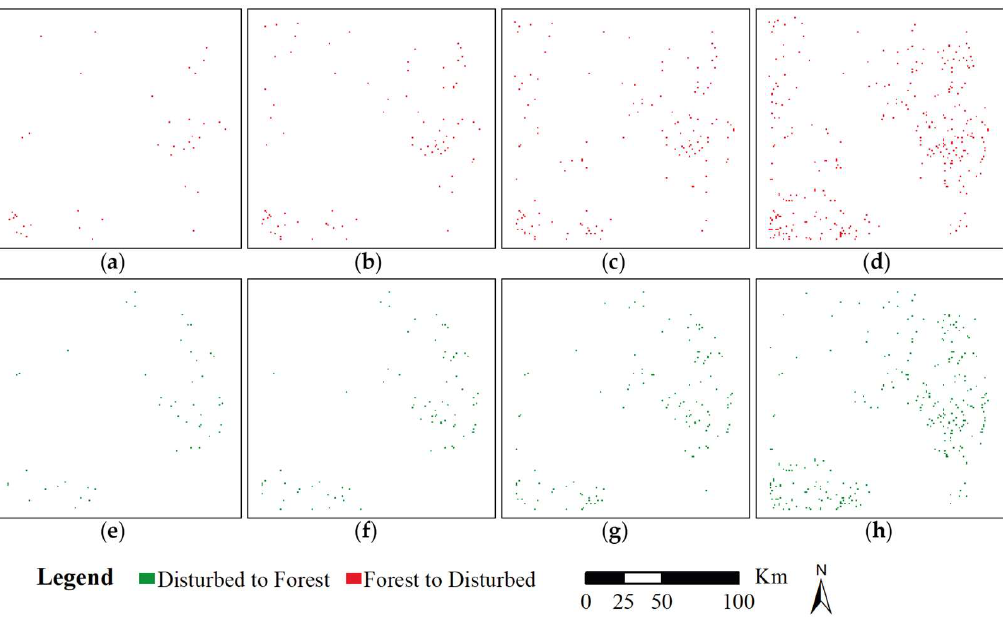
Figure 8. Geographic comparison of land transition area resulting from various time intervals. ( a ), ( b ), ( c ), and ( d ) are the sum of forest increase resulting from respective scenarios of 10 yrs, 5 yrs, 2 yrs, and annual. ( e ), ( f ), ( g ) and ( h ) are the sum of forest decrease resulting from respective scenarios of 10 yrs, 5 yrs, 2 yrs, and annual.